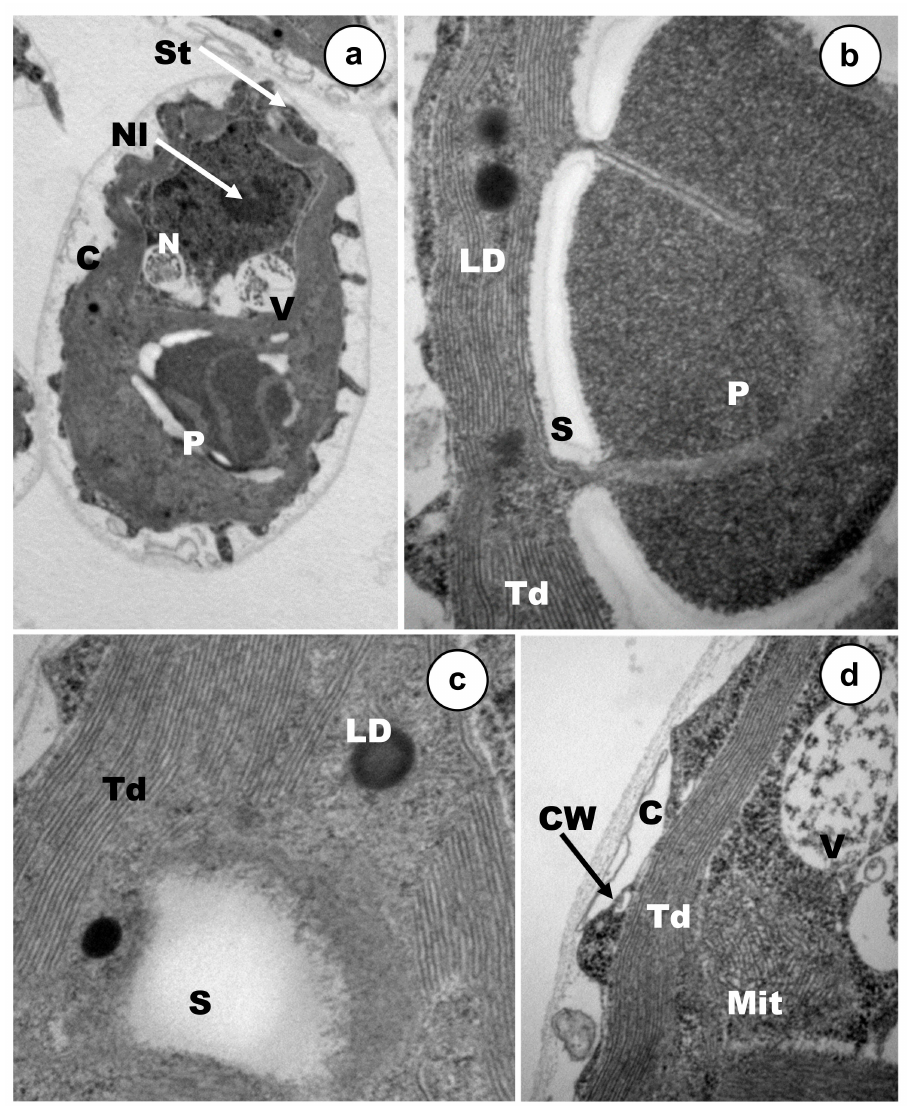
Figure 6. Ultrastructural features of C. acidophila RT46 control cells. ( a ) Longitudinal section of a vegetative cell (15k × ), ( b ) cytoplasm view in detail, showing the thylakoidal membranes, lipid droplets, pyrenoid, and the starch deposits around this structure (80k × ), ( c ) thylakoid arrangement and energy reserves (80k × ), ( d ) cellular surface appearance and a mitochondrial ultrastructure (50k × ). S— Starch deposits; P—pyrenoid; St—stigma; V—vacuole; Td—thylakoids; C—capsule; Np—nanoparticles-like; Mit—mitochondria; CW—cell wall; N—nucleus;